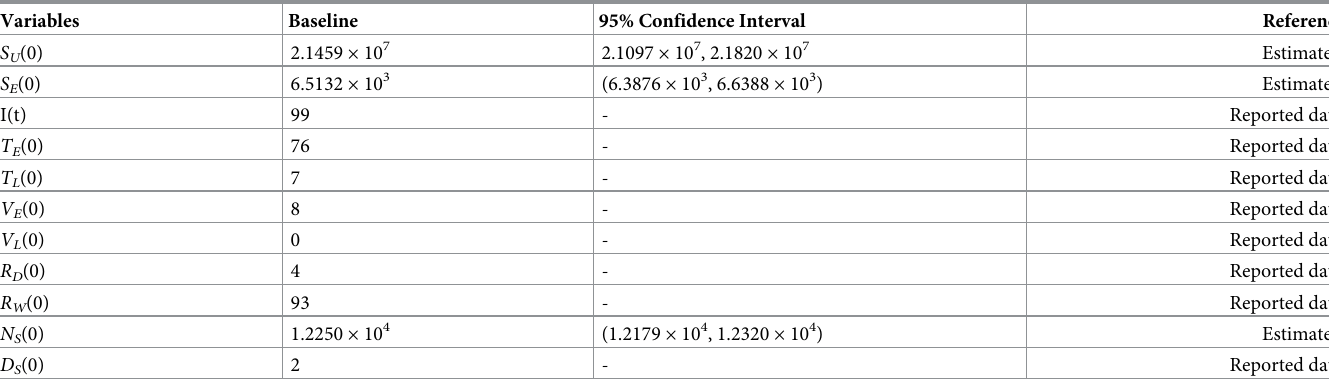
Table 4. Estimated initial condition of state variables.